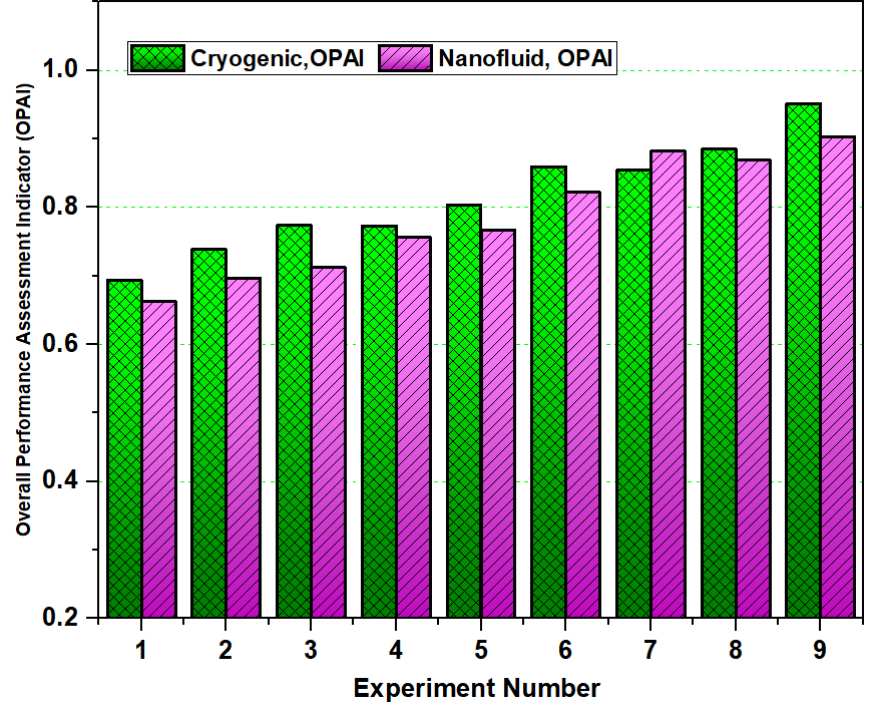
Figure 5. Calculation of the Overall Performance Assessment Indicator for case study 2.